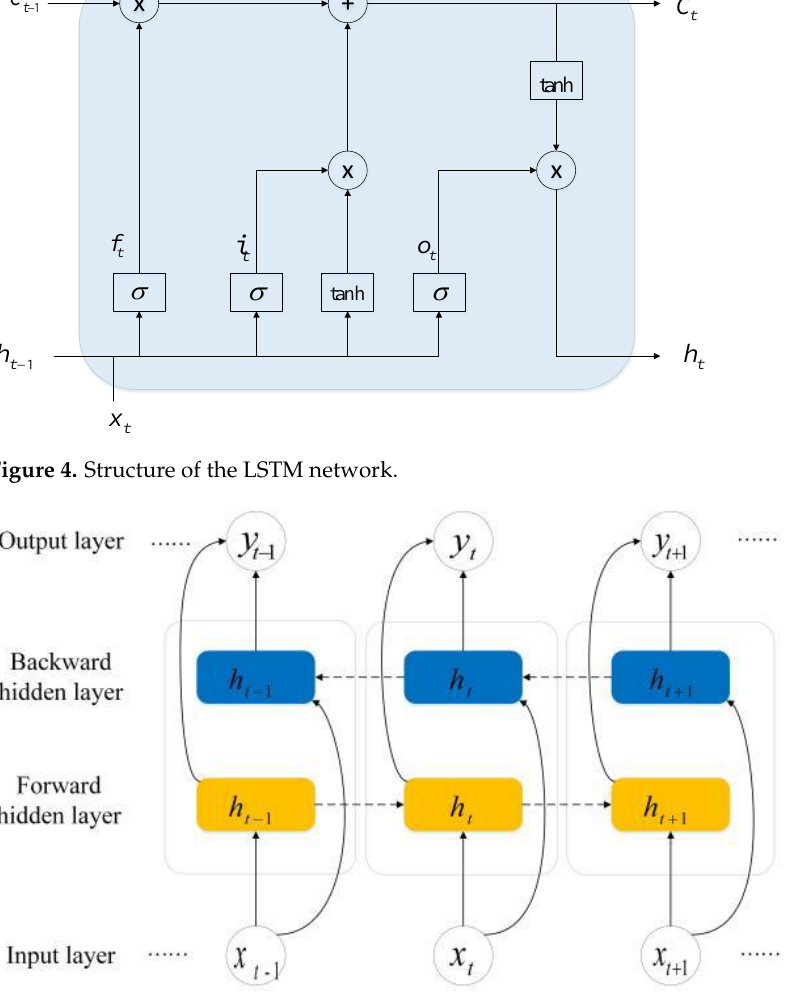
Figure 5. Structure of the BiLSTM network.